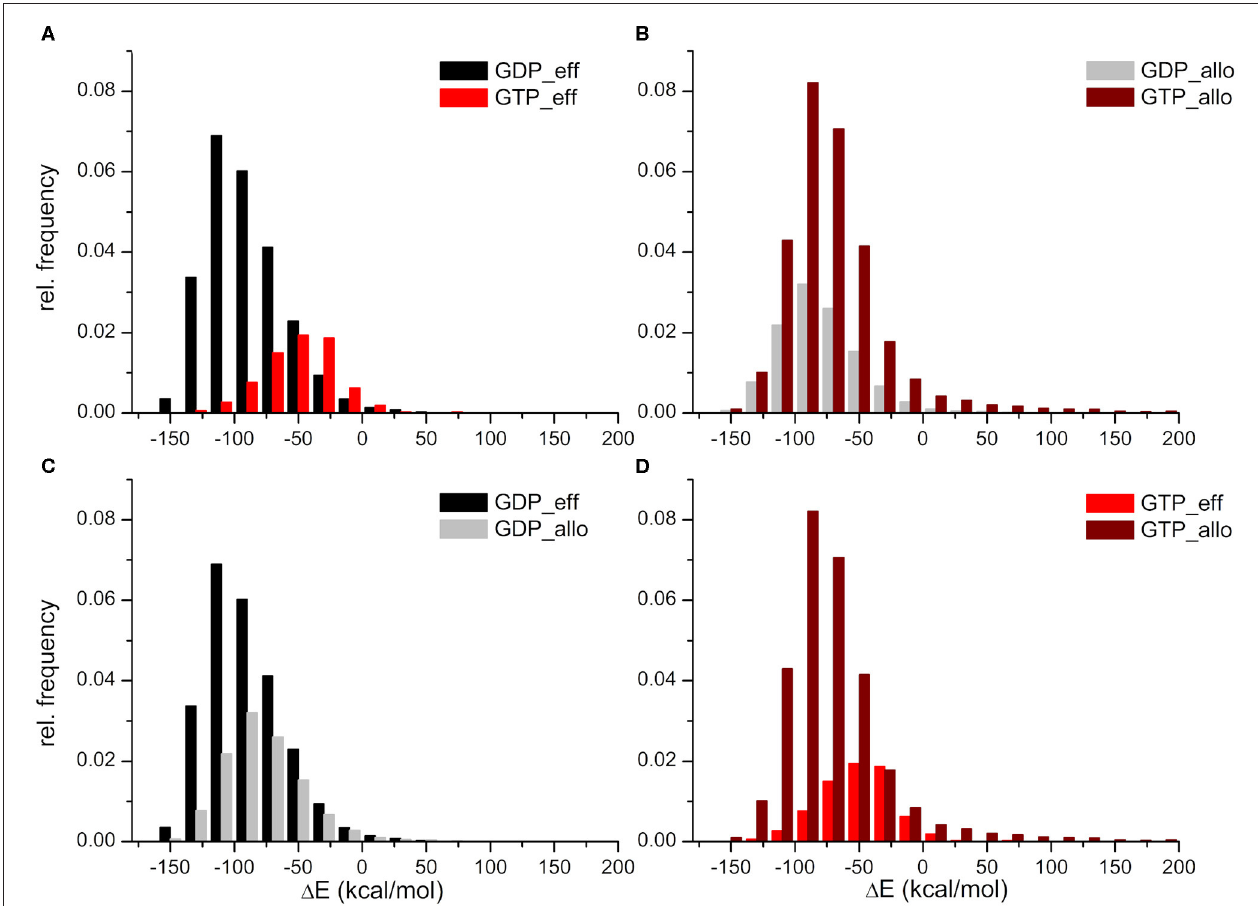
FIGURE 3 | Distributions of interaction energies between the HVR and the catalytic domain of K-Ras4B, within the GDP- and GTP-bound population. HVR interactions (A) with the effector lobe in the GDP-bound (black) and GTP-bound (red) state; (B) with the allosteric lobe in the GDP-bound (gray) and GTP-bound (wine) state; (C) with the effector (black) and the allosteric (gray) lobe in the GDP-bound state; and finally (D) with the effector (red) and the allosteric (wine) lobe in the GTP-bound state.